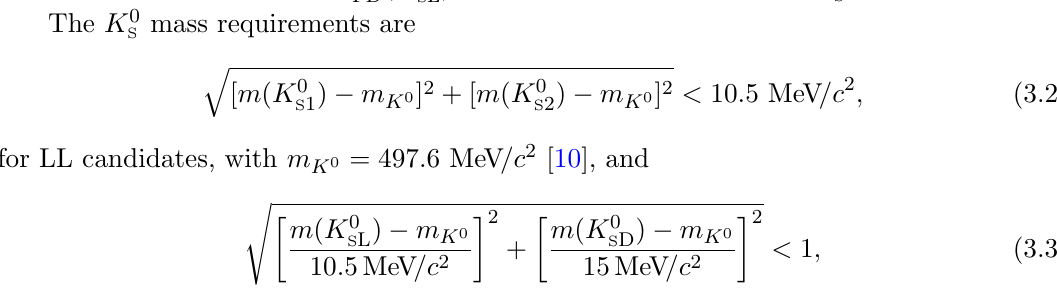
the quantity log (cid:31) 2 for K 0 pairs in the LL sample. In the (cid:12)gure, four separate regions FD S are visible. The upper right part of the plot, where both K 0 (cid:13)ight distances, is the D 0 ! K 0 K 0 signal, while the upper left and lower right regions S S correspond to D 0 ! K 0 (cid:25) + (cid:25) (cid:0) decays. The lower left is populated by D 0 ! (cid:25) + (cid:25) (cid:0) (cid:25) + (cid:25) S